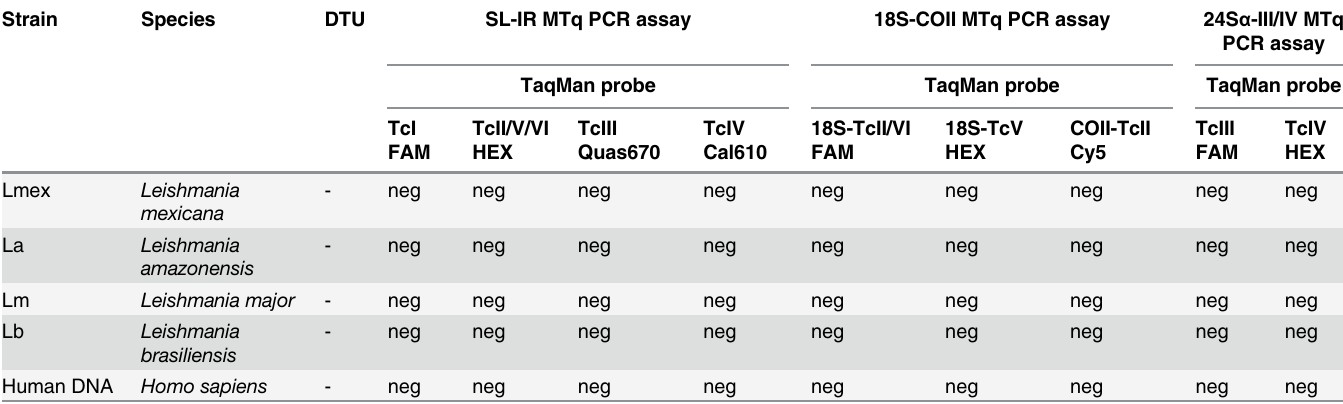
cases of TcIV-SA, TcV and TcVI, sensitivity was lower (1 pg DNA/reaction tube) with Eff of 80%, 88% and 86%, respectively (Fig 2). The 18S-COII MTq-PCR reaction rendered a sensitivi- ty of 100 fg DNA/reaction tube for strains representing TcV (Eff: 82%) and TcVI (Eff: 83%) and 1 pg DNA/reaction tube for TcII (Eff: 77% and 70% using the 18S-FAM and the COII-Cy5,